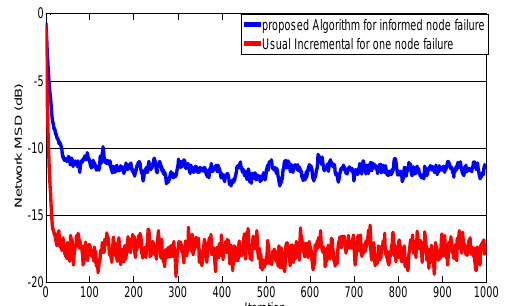
Figure 11. Transient network MSD for usual (red) and proposed (blue) incremental LMS for first informed node